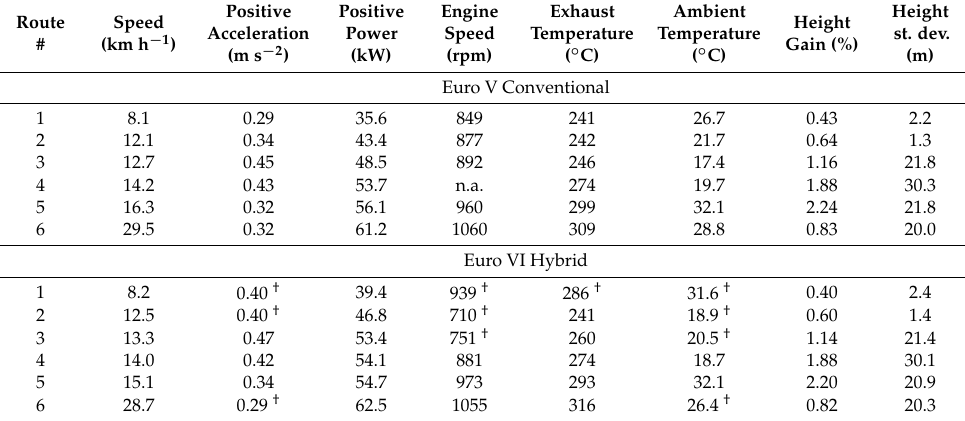
Table 3. Overview of the mean driving and operation conditions per route and bus technology.